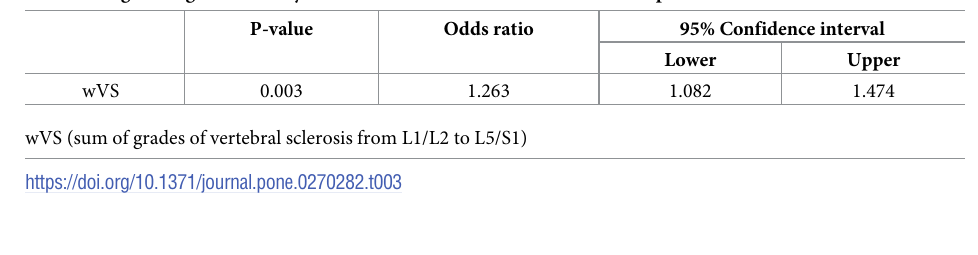
Table 3. Logistic regression analysis for the factors associated with low back